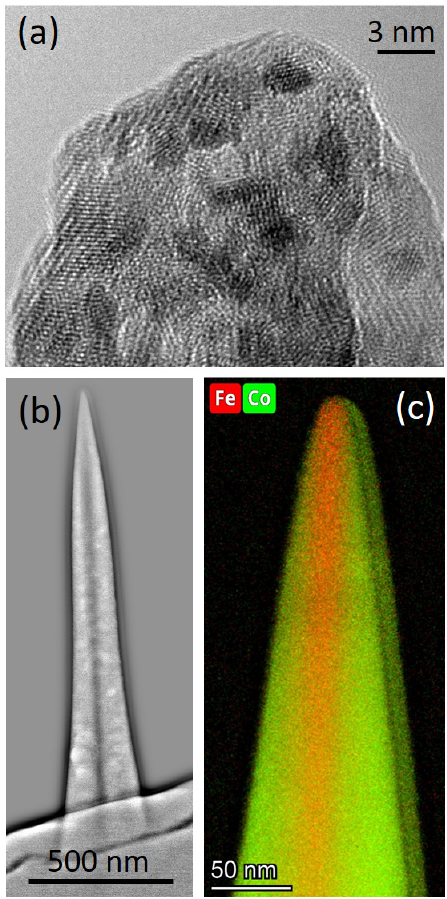
Figure 5. TEM characterization of Co 3 Fe pillars. ( a ) high ‐ resolution TEM image of the tip region confirms the high degree of crystallinity, the contamination ‐ free character, and the sharp apex. ( b ) confirms the high degree of crystallinity, the contamination-free character, and the sharp apex. high ‐ pass filtered TEM ‐ HAADF image of a 20 keV / 81 pA Co 3 Fe α‐ pillar, which reveals a dark core ( b ) high-pass filtered TEM-HAADF image of a 20 keV/81 pA Co 3 Fe α -pillar, which reveals a dark in the center. ( c ) Scanning ‐ TEM EDX map of Fe and Co distribution at the tip region, which reveals core in the center. ( c ) Scanning-TEM EDX map of Fe and Co distribution at the tip region, which Fe ‐ richer core, while surrounding areas are closer to the expected Co 3 Fe composition. reveals Fe-richer core, while surrounding areas are closer to the expected Co 3 Fe